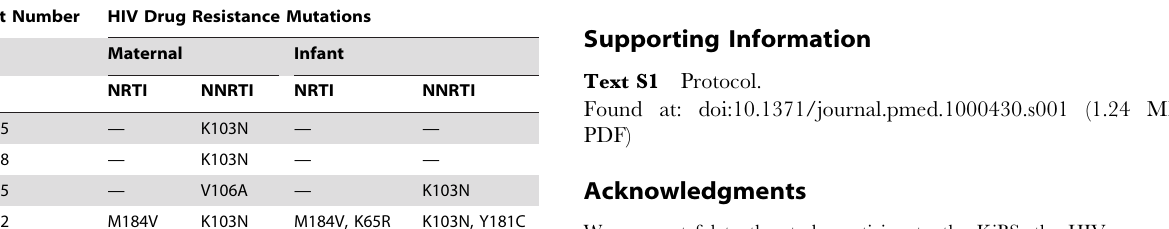
troviral therapy during breastfeeding and those caring for infants exposed to antiretroviral through breast milk will need to be cognizant of this issue and consider monitoring these infants more closely and tailoring their treatment accordingly.